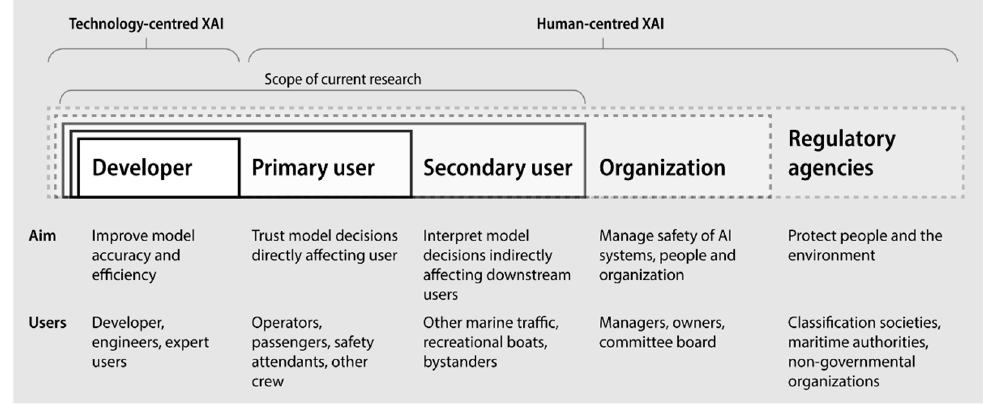
Figure 4. Human-centered XAI expands the field’s audience towards end user stakeholders.